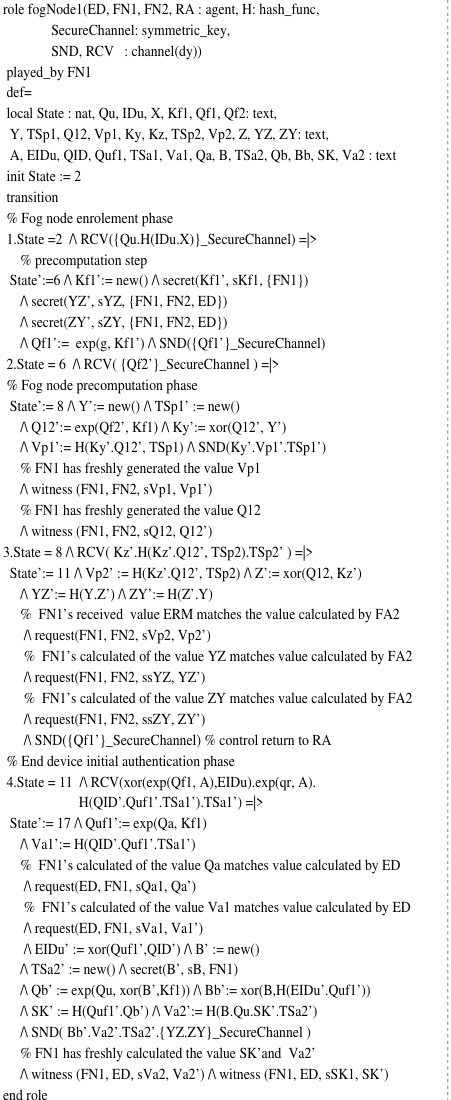
Figure 7. HLPSL role specification for fog node 1 ( FN 1 )